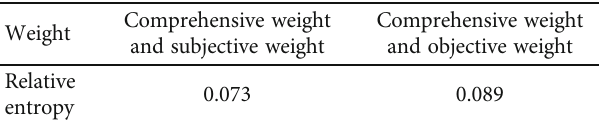
Table 10: Relative entropy of